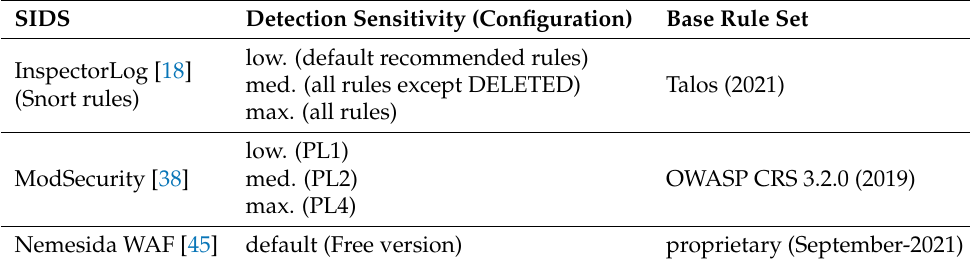
Table 1. SIDS and configurations under study.